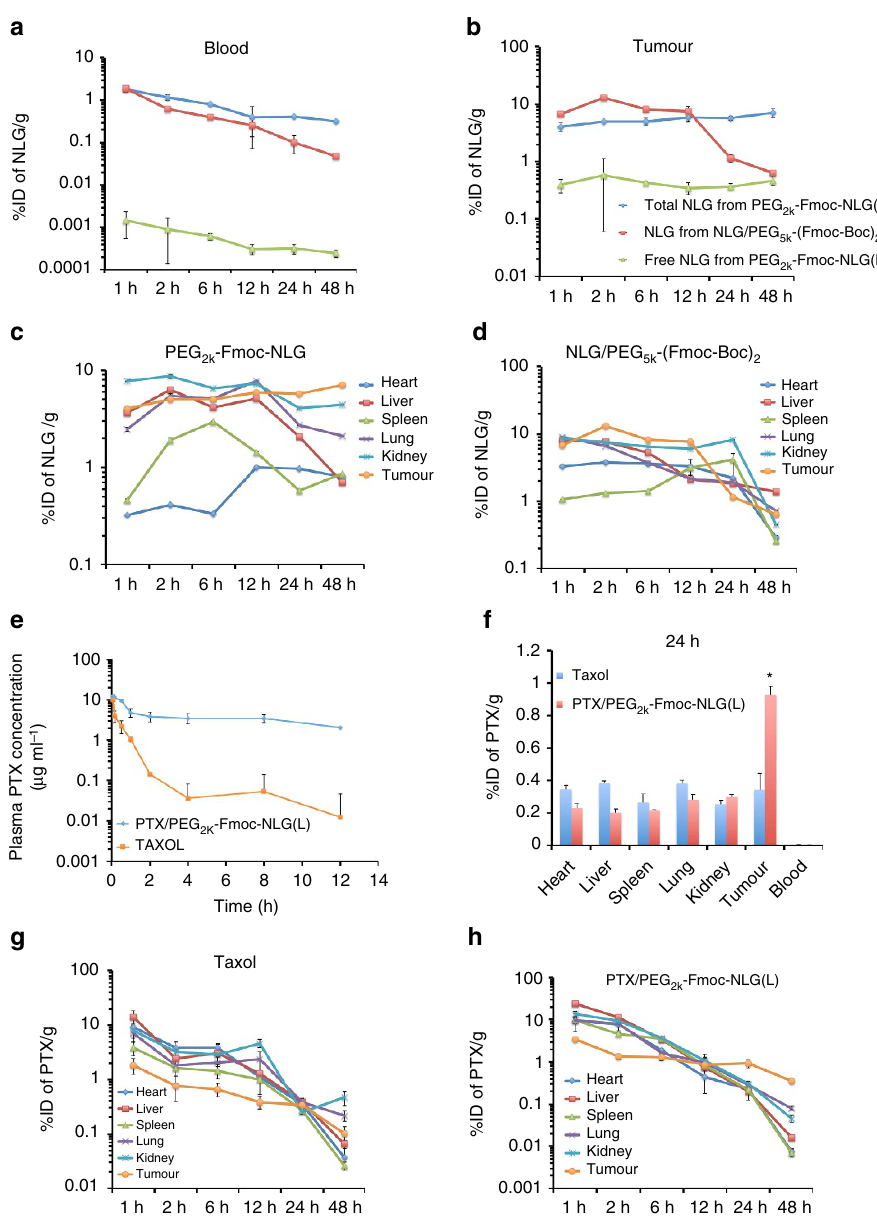
Figure 4 | Pharmacokinetics and biodistribution of drug-free and PTX-loaded micelles. ( a , b ) The kinetics of NLG in blood ( a ) and tumour ( b ) in 4T1.2 tumour-bearing mice following i.v. administration of PEG 2k -Fmoc-NLG(L) in comparison to NLG-loaded PEG 5k -(Fmoc-Boc) 2 micelles (25mg NLG per kg). ( c , d ) Tissue distribution of NLG in 4T1.2 tumour-bearing BALB/c mice following i.v. administration of PEG 2k -Fmoc-NLG(L) ( c ) or NLG-loaded PEG 5k -(Fmoc-Boc) 2 micelles ( d ) at a NLG dose of 25mgkg (cid:2) 1 . ( e ) Blood kinetics of PTX in BALB/c mice following i.v. administration of Taxol or PTX/PEG 2k -Fmoc-NLG(L) mixed micelles at a dose of 10mg PTX per kg. ( f ) Tissue distribution of PTX in 4T1.2 tumour-bearing BALB/c mice 24h following i.v. administration of Taxol or PTX/PEG 2k -Fmoc-NLG(L) mixed micelles at a PTX dose of 10mgkg (cid:2) 1 . * P o 0.05 ( N ¼ 5). ( g , h ) Tissue distributions of PTX at various time points following i.v. administration of Taxol ( g ) or PTX/PEG 2k -Fmoc-NLG(L) mixed micelles ( h ) (10mg PTX per kg). All data represent means ±